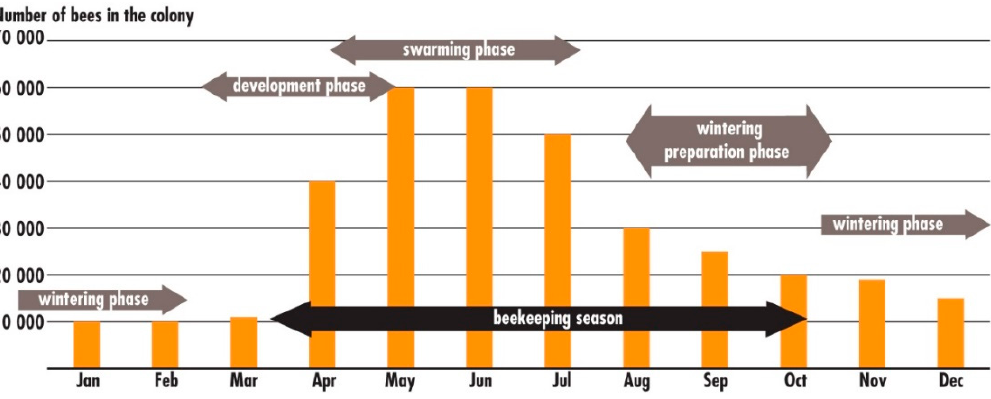
Figure 6. Mean theoretical honeybee population per hive and by season in temperate regions (Source: UNEP